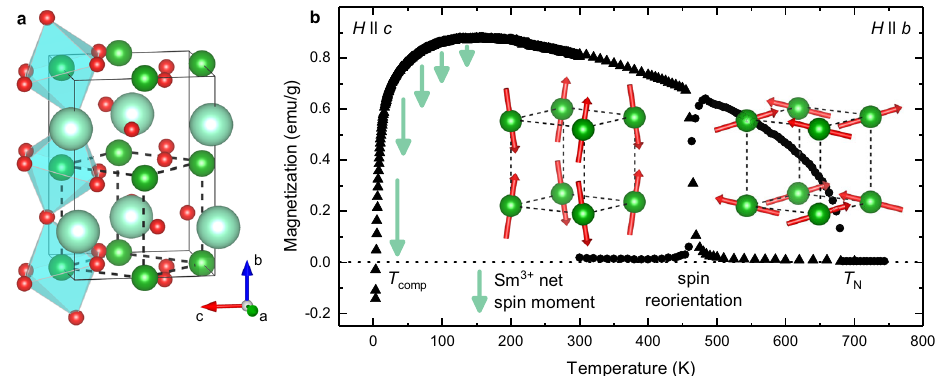
Fig. 1 Magnetic properties of SmFeO 3 . a Rare-earth orthoferrite Pnma structure 55 . Oxygen, iron and rare-earth ions are given in red, green and turquoise, respectively, FeO 6 octahedra in pale blue. Solid and dashed lines describe the orthorhombic unit cell and the pseudo-cubic setting, respectively. b Evolution of the magnetization (data taken from Ref. 19 ): at the Néel temperature T N , the Fe 3 + spins order in a A x F y G z -type fashion. At the spin reorientation, the magnetic order changes to C x G y F z . The spin canting leads to a net-magnetization. Both Fe 3 + spin structures are sketched in pseudo-cubic settings. At low temperatures, the iron magnetism induces the magnetic Sm 3 + sublattice with a net-magnetic moment (turquoise arrows) aligning antiparallel to the iron moments, which leads to a magnetic compensation point T comp at 3.9